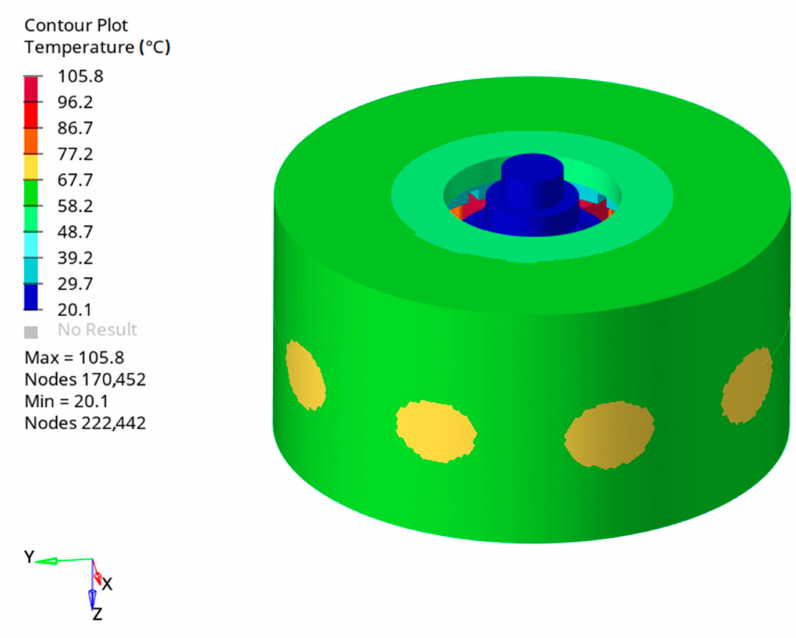
Figure 20. The temperature distribution in the AFPM motor’s